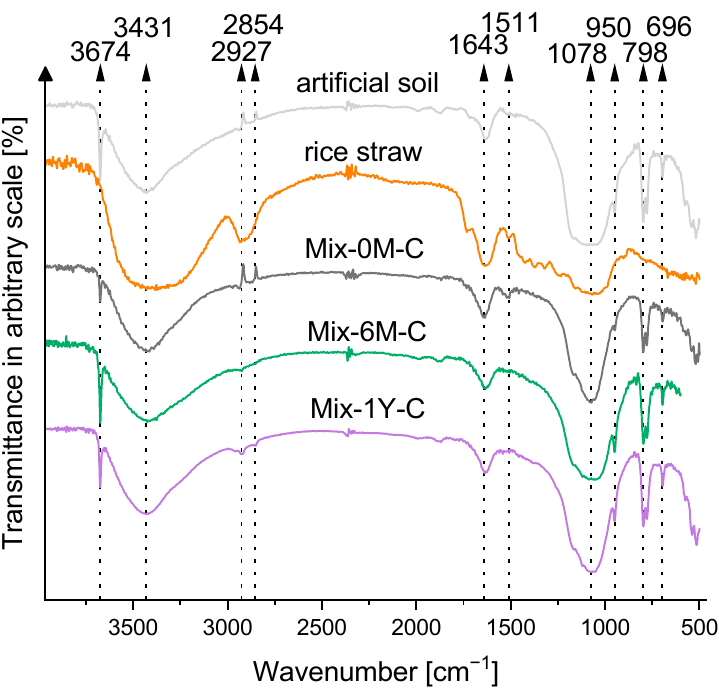
Figure 2. FT-IR spectra of rice straw-artificial soil mixtures with 0 and 6 months, and 1 year of humification (Mix-0M-C, Mix-6M-C, Mix-1Y-C), rice straw only, and artificial soil Figure 2. FT ‐ IR spectra of rice straw ‐ artificial soil mixtures with 0 and 6 months, and 1 year of hu ‐